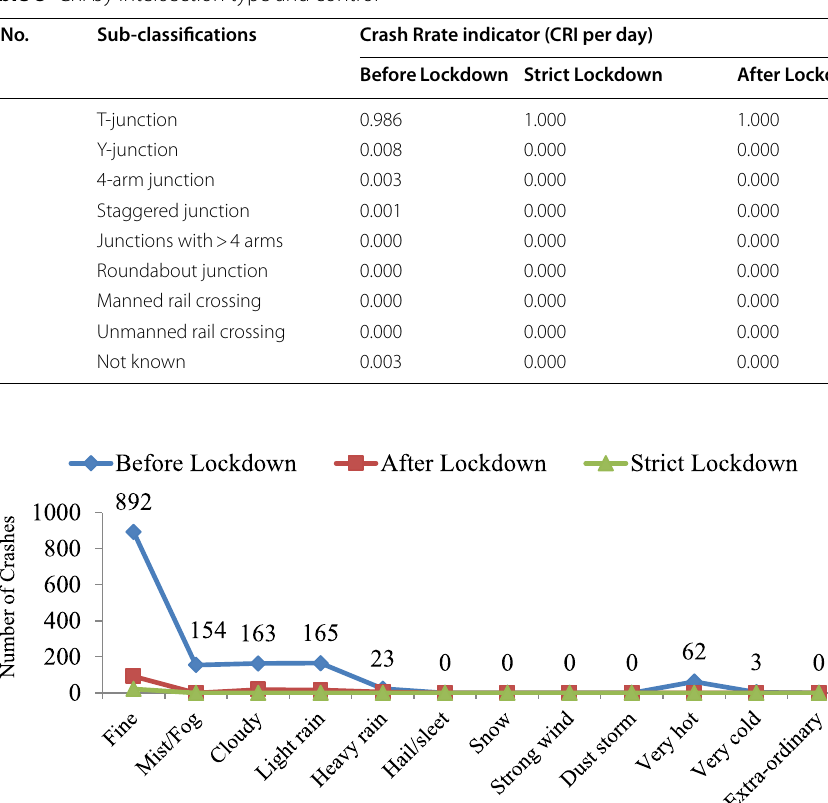
Fig. 8 Analysis of crash data by weather condition